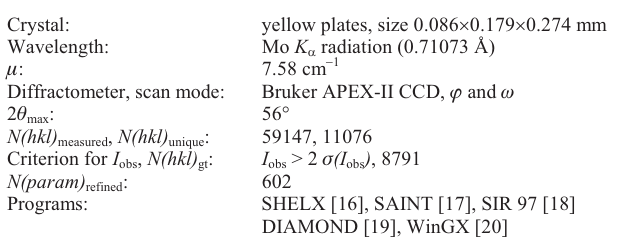
Table 1. Data collection and